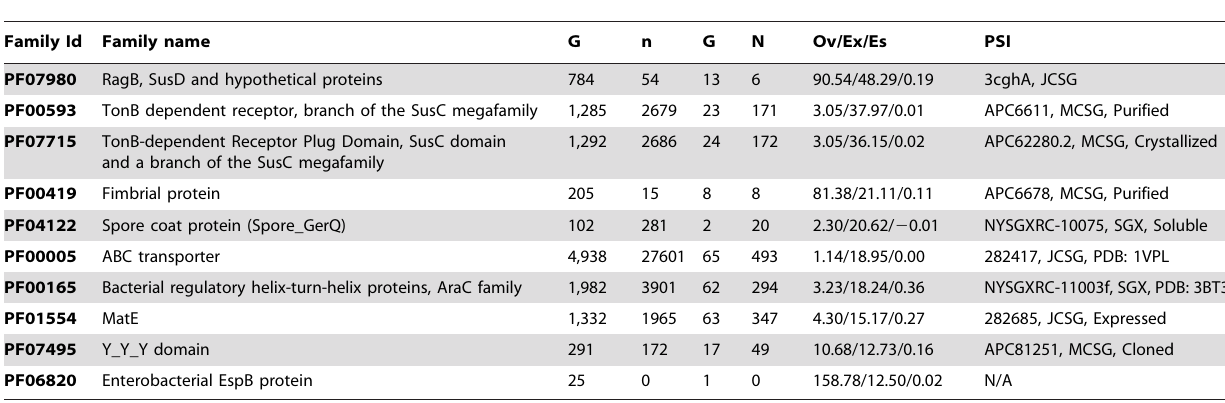
Table 2. The 10 most expanded (Ex) PfamA families in human gut microbiome.